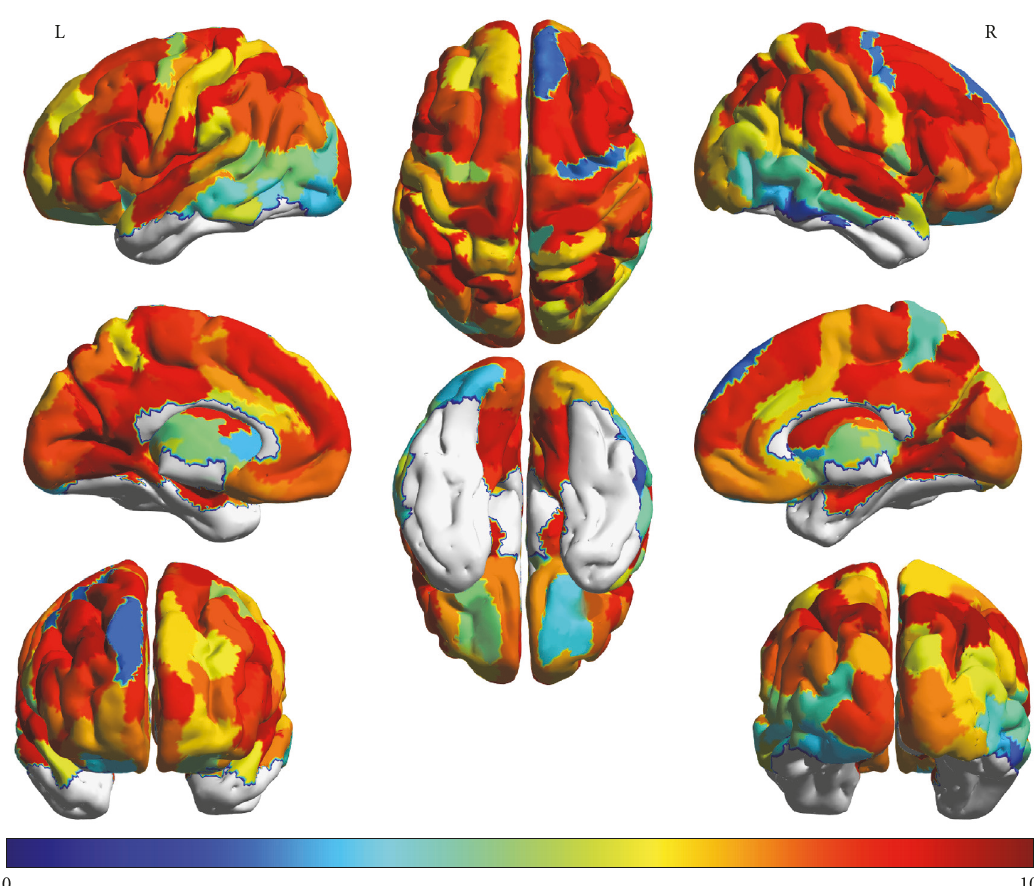
Figure 6: Consistency of the assignment of brain regions to modules measured as the frequency of occurrence of the node with a specific label (in percent) for Pearson’s